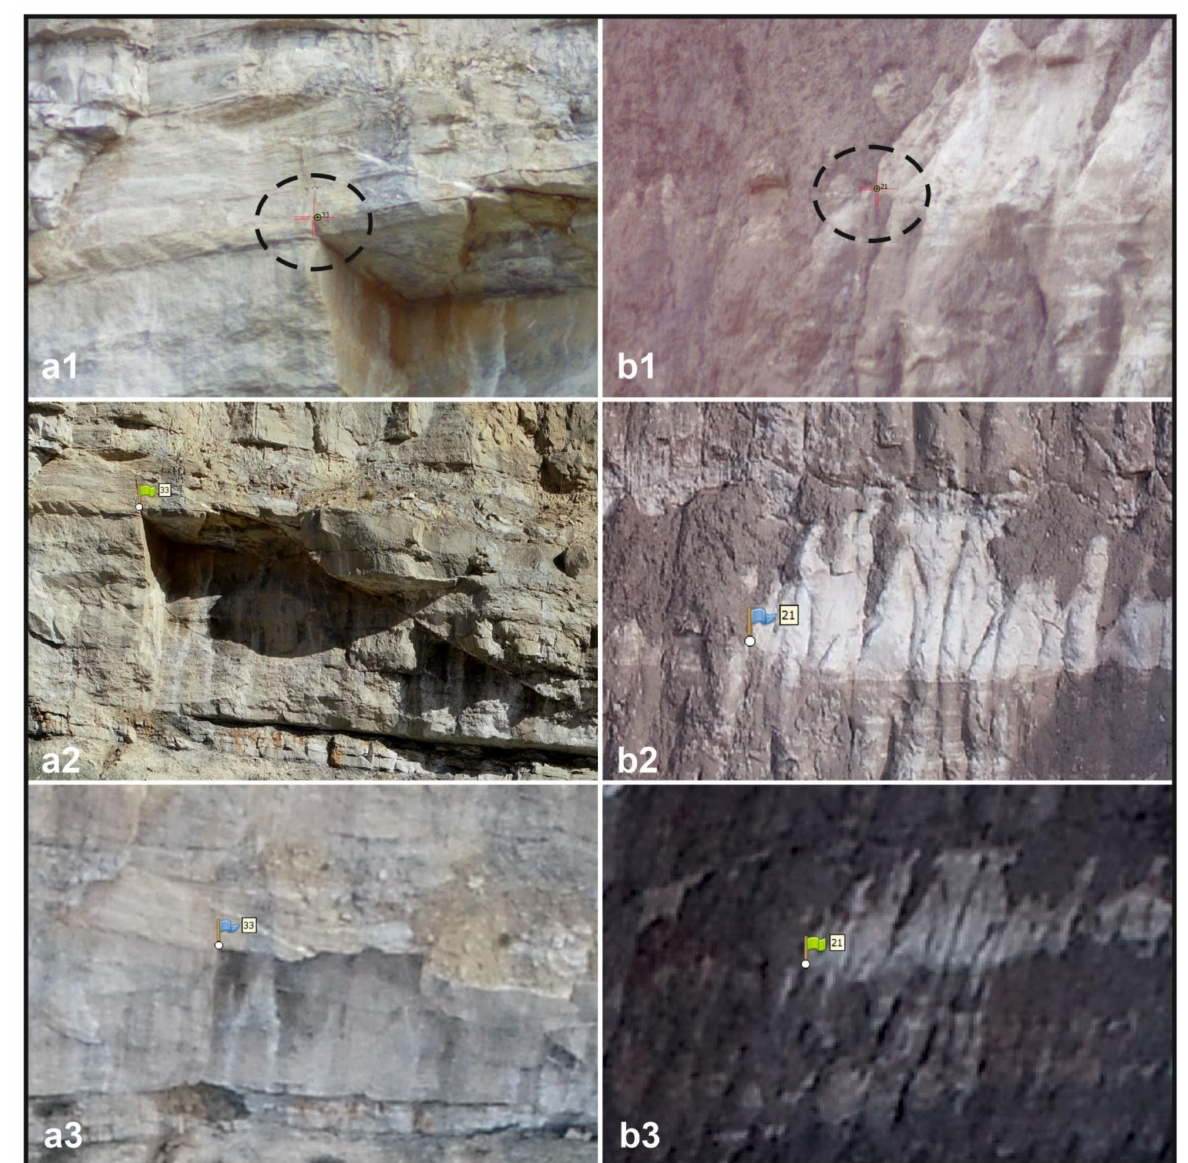
Figure 10. Two types of natural marks measured with the total station ( 1 ): a characteristic corner edge in a rock ( a ) and a change in color ( b ). These corresponding points are also shown in images taken by the drone in the facade-nadir ( a2 , b2 ) and AMSL-40 ◦ -off-nadir ( a3 , b3 ) flights,